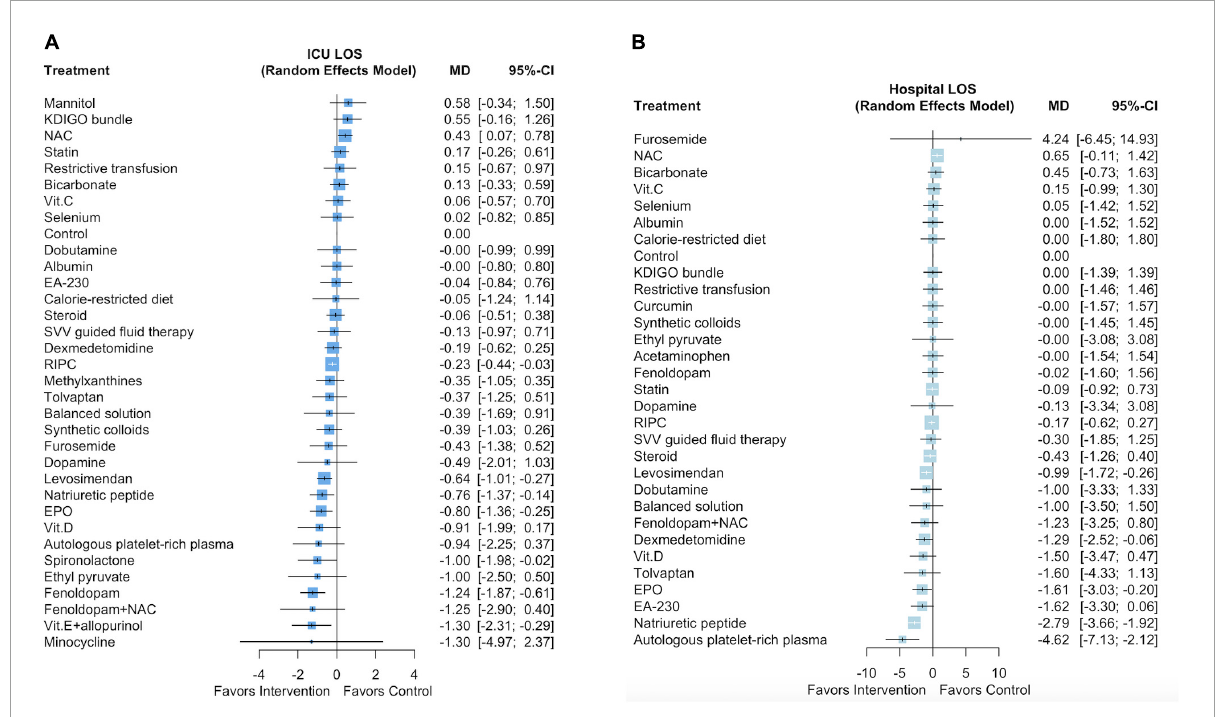
FIGURE3 Forest plot of network meta-analysis for ICU (A) and hospital (B) length of